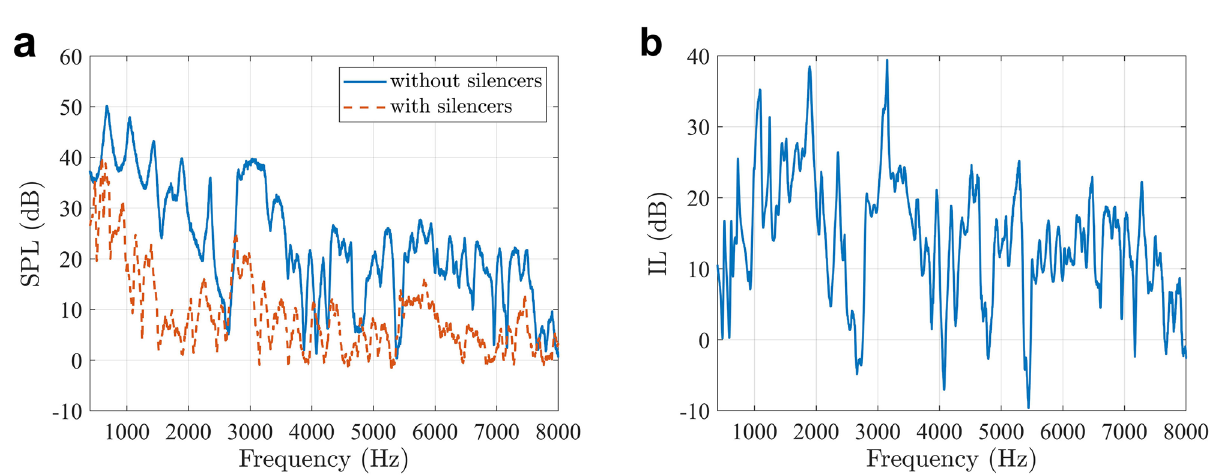
Figure 7. (a) The measured SPLs at the evaluation point between 400 and 8000 Hz with and without the silencers. (b) The insertion loss of the silencers in the